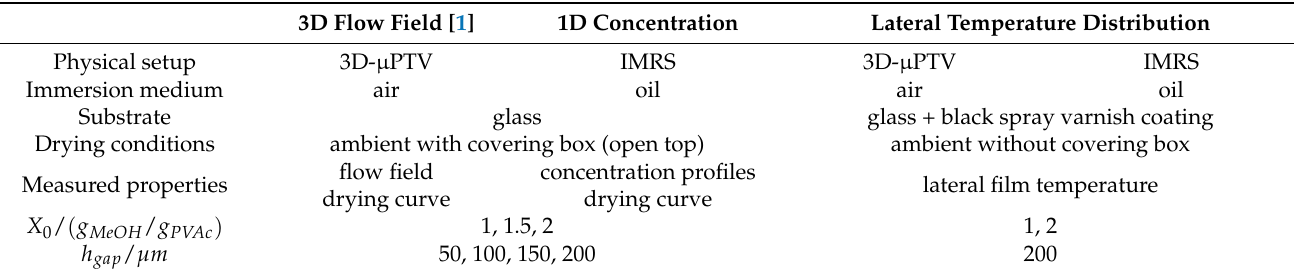
Figure 2. Schematic drawing of the substrate temperature control during IMRS ( a ) and 3D- µ PTV ( b ) drying experiments. The setups slightly differ in metal support geometry and only IMRS uses oil immersion. Table 1. Summary of all experimental